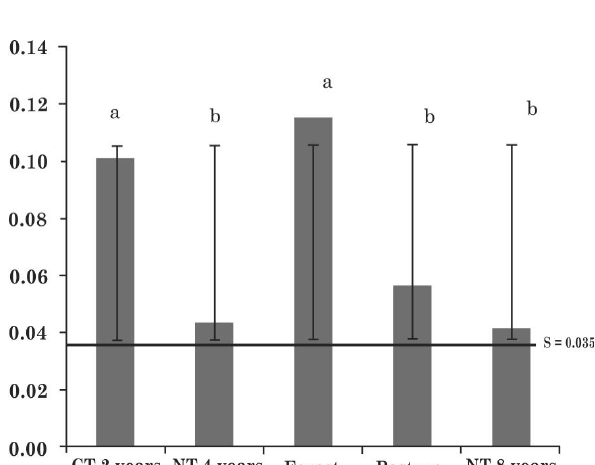
Figure 1. S index values in the areas of two years conventional tillage (CT2 years), four years no- tillage (NT4), forest, grassland and eigth years no-tillage (NT8), in three layers, of an Oxisol. The horizontal line refers to the critical S index (Dexter, 2004a). ± standard deviation. The letters compare the layers of the areas by the Tukey test at 5 %.